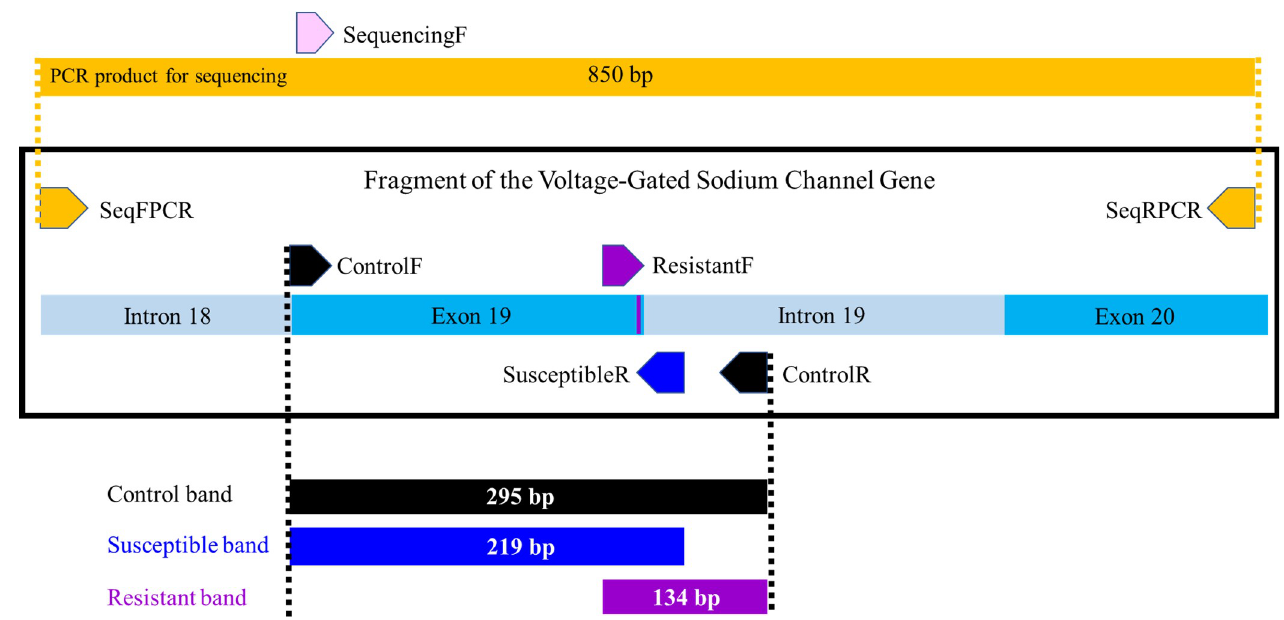
Fig 4. Schematic primer map and expected PCR products of the genomic kdr region. The schematic is shown in the genomic forward orientation for clarity. The exon and intron numbers in the light blue boxes are according to the sodium channel sequence of the S-Lab strain mosquito published by He et al. (2012) [17]. The kdr -like mutation (L982F) is marked as vertical purple line on Exon19. The expected product sizes of diagnostic PCR: 295 bp control band in black is generated by ControlF and ControlR; 219 bp susceptible band in dark blue is generated by ControlF and SusceptibleR; 134 bp resistant band in purple is generated by ResistantF and ControlR. The 850 bp PCR product generated by primers in orange (SeqFPCR and SeqRPCR) is utilized with the pink primer (SequencingF) for sequencing.